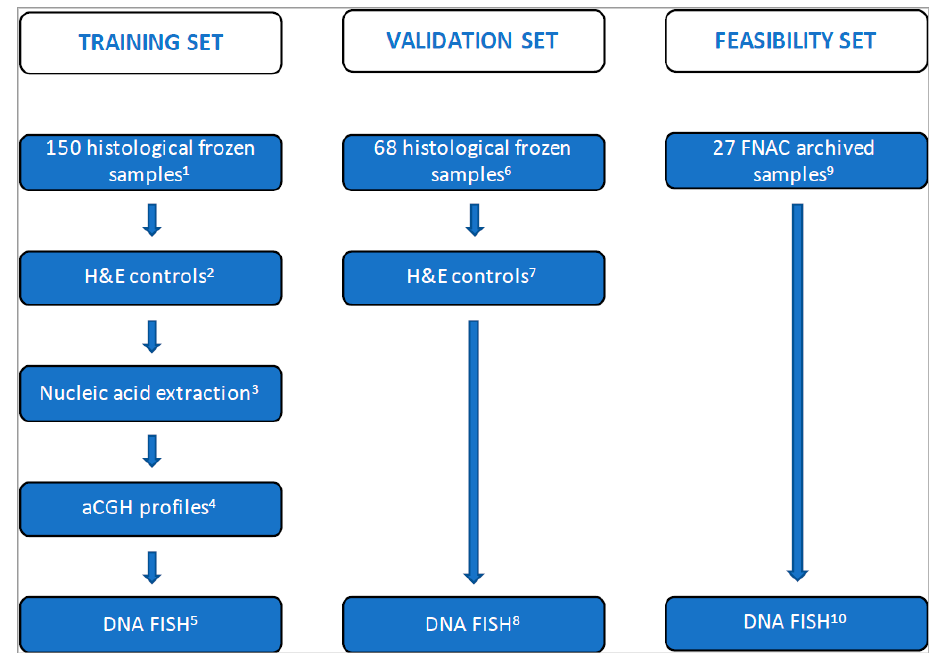
Figure 1. Flow chart of the study. Abbreviations: pts: patients; H&E: hematoxylin & eosin; aCGH: array comparative genomic hybridization; DNA FISH: DNA fluorescent in situ hybridization; hyb: hybridization; FNAC: fine needle aspiration cytology. Training set: 1 from 87 pts; 2 from 69 pts (after exclusion of 18 cases: 10 atypical adenomas, four oxyphilic neoplasms, two uncertain diagnoses, one follicular variant of papillary carcinoma, one non-tumoral); 3 from 67 pts (after exclusion of two cases with insufficient DNA for analysis); 4 from 66 pts (after exclusion of one case with doubtful aCGH result); 5 from 44 pts (with available residual tissue). Validation set: 6 from 68 pts; 7 from 60 pts (after exclusion of eight cases: six oxyphilic neoplasms, one atypical adenoma, one metastatic tumor); 8 from 60 pts. Feasibility set: 9 from 27 pts (preoperative routinely stained FNAC with histological assessment of the corresponding postoperative tissue); 10 from 27 pts.